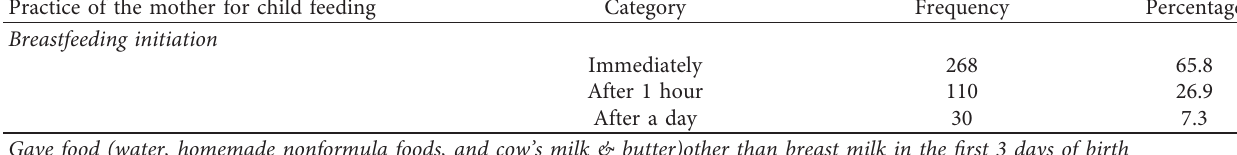
Table 3: Breastfeeding practice of the mother having a child less than 2 years of age, Ethiopia, 2019.